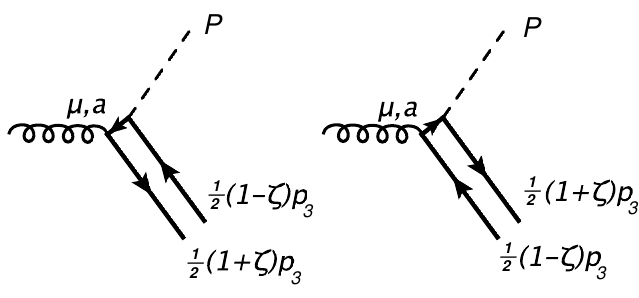
Figure 5 . Feynman diagrams for the tensor amplitude T (cid:22)a;b for g (cid:3) ! H + t (cid:22) t at LO. The integrand is the product of the hard form factor e F